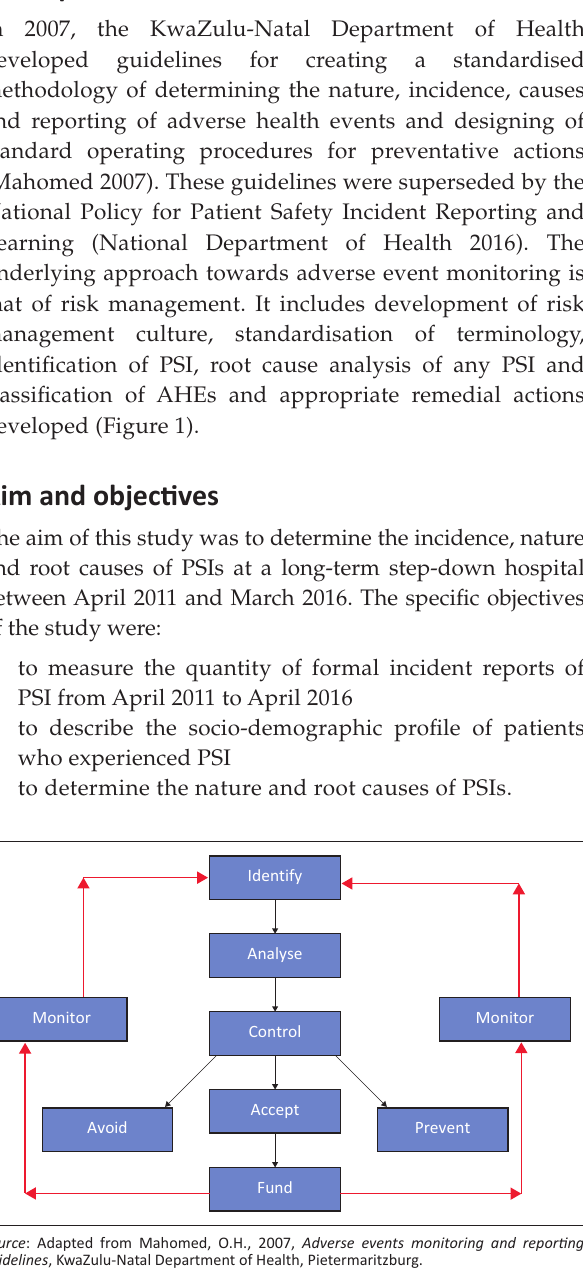
FIGURE 1: Risk management cycle for adverse events